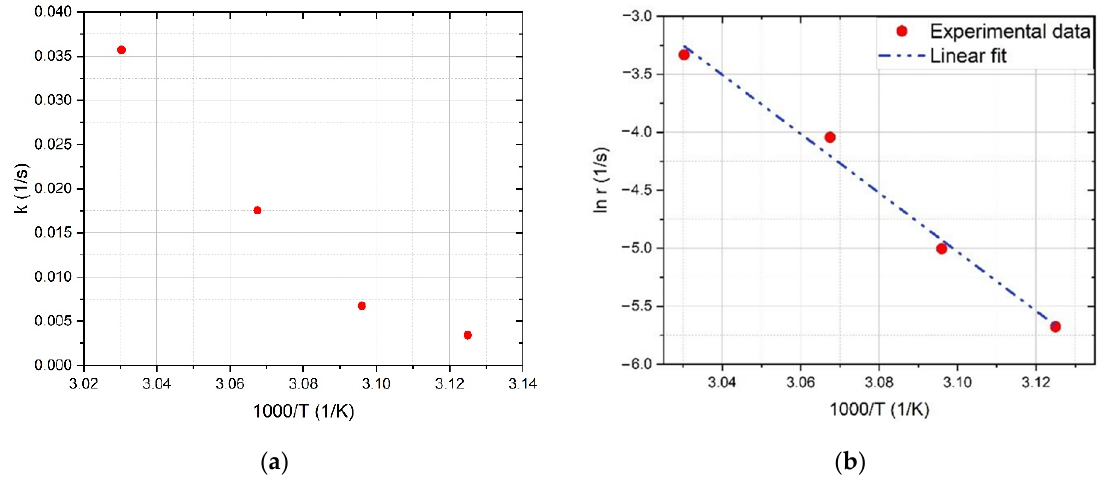
Figure 5. Arrhenius plot of the a-SiN x :H thin film sputtered at a H 2 flow of 6 sccm (S4): ( a ) experimental data, ( b ) linear fit.